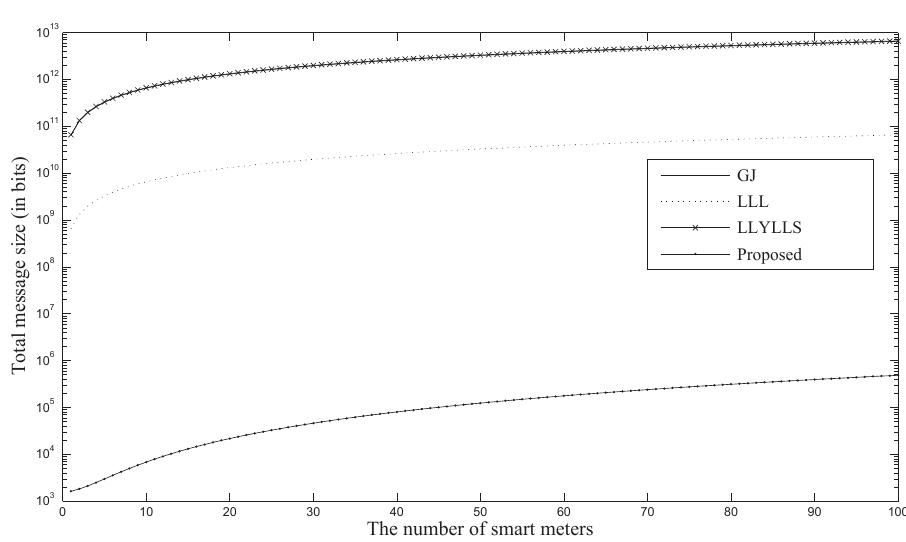
Figure 4. Total message size for an aggregation (log